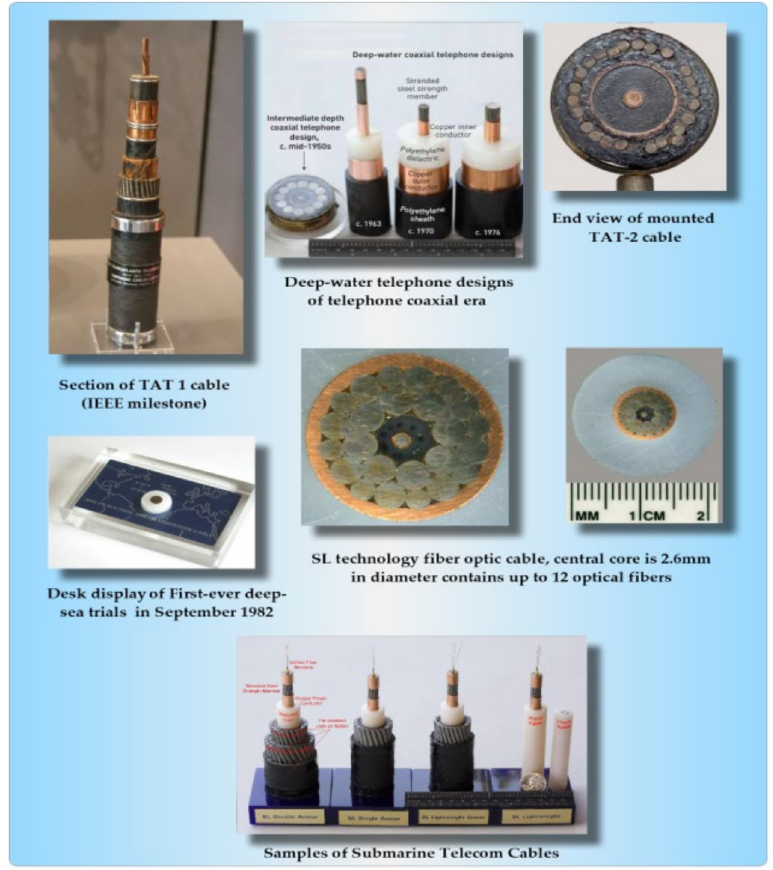
Figure 1. Submarine network elements’ evolution (1956–2022)